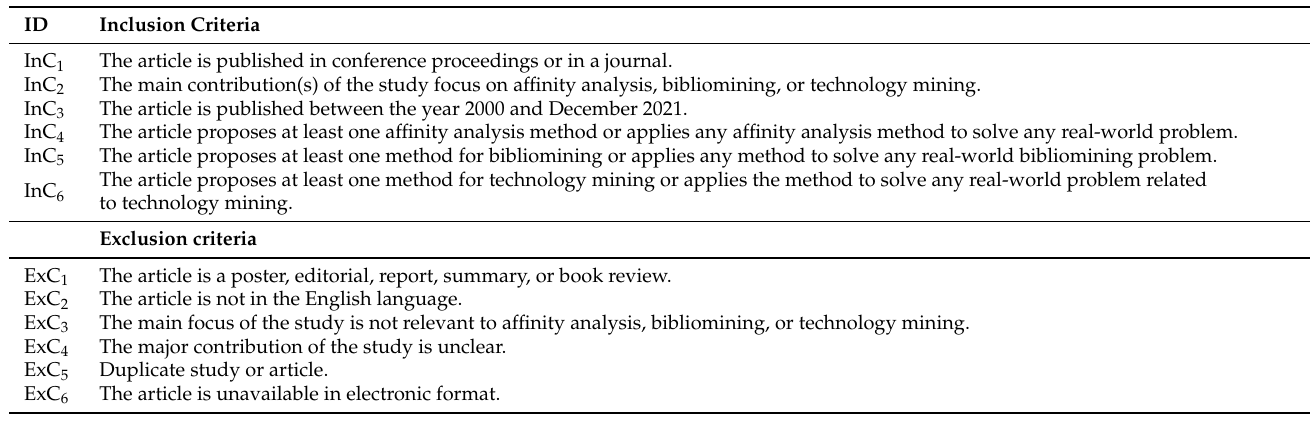
Table 1. Inclusion and exclusion criteria for determining relevant papers.